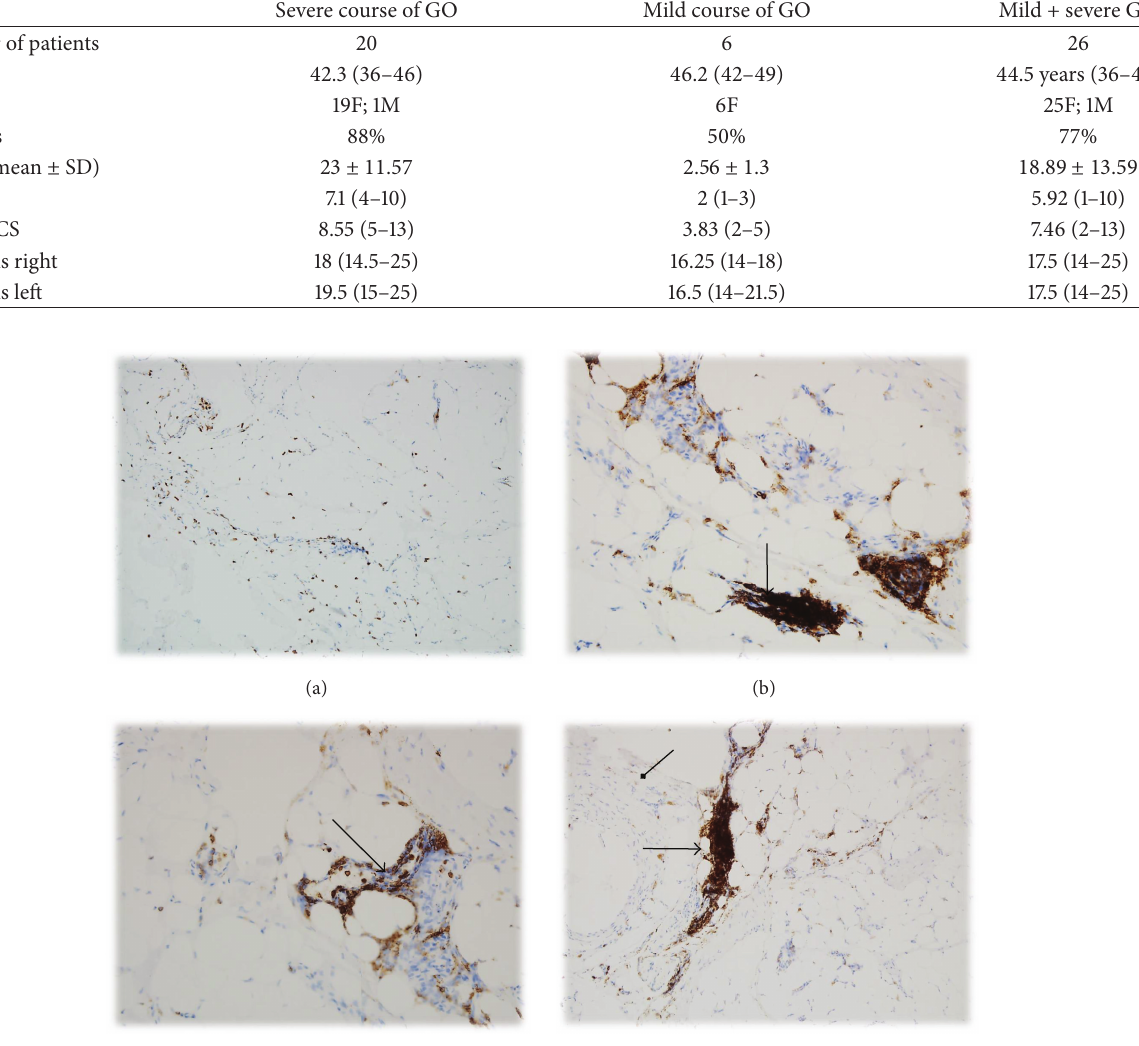
Figure 1: (a) Strong and diffuse TCR expression in lymphoid cells within the mild Graves ophthalmopathy. Magnification: 100x. (b) Focuses of the lymphoid cells aggregation (TCR expression) in the mild Graves ophthalmopathy. Magnification: 200x. ((c), (d)) Strong and diffuse TCR receptor expression in lymphocytes within severe Graves ophthalmopathy. Magnification: 200x, 100x (the arrows show T cells and